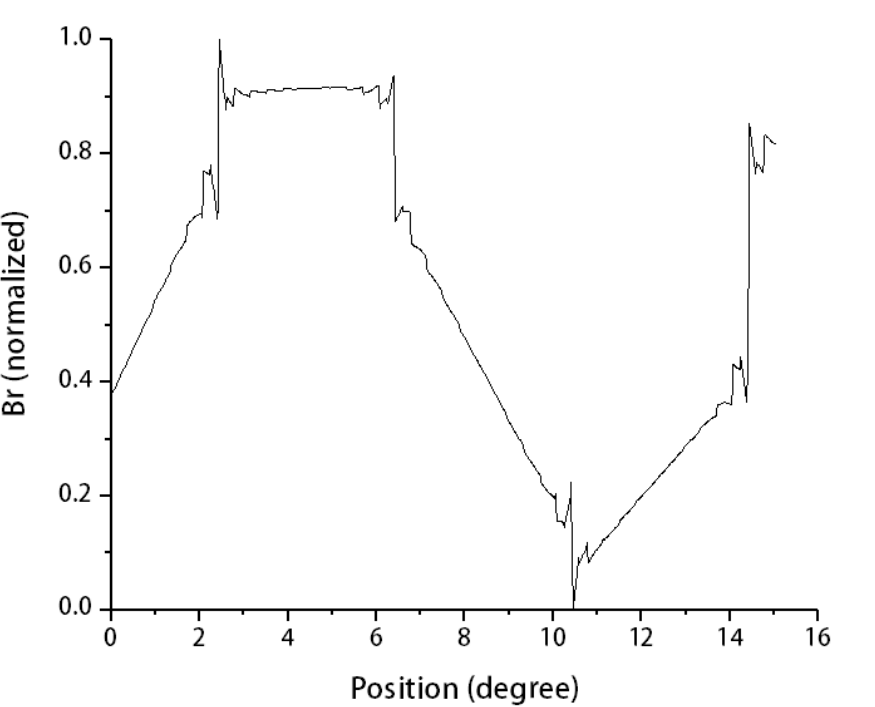
Figure 11. The distributions in space of radial flux density in air gap under 0.15 mm eccentricity. (one